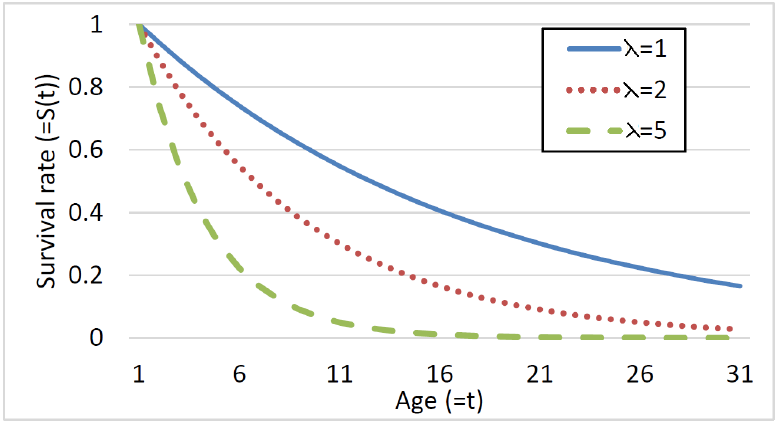
Figure 1. An example of exponential survival